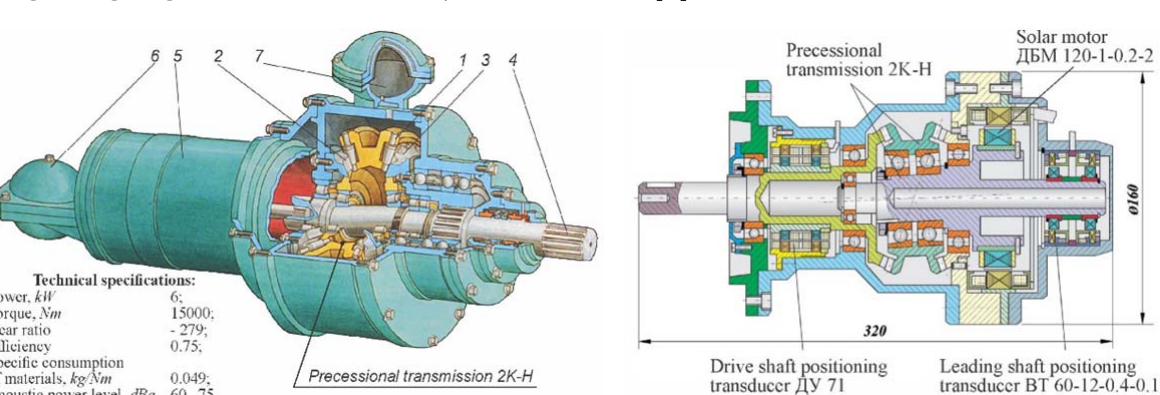
Figure 1 . Precessional submersible gearmotor with Figure 2. Precessional electromechanical bolt gear, i= -279. module with toothed gear ( i= -279) for the operation of the space flight